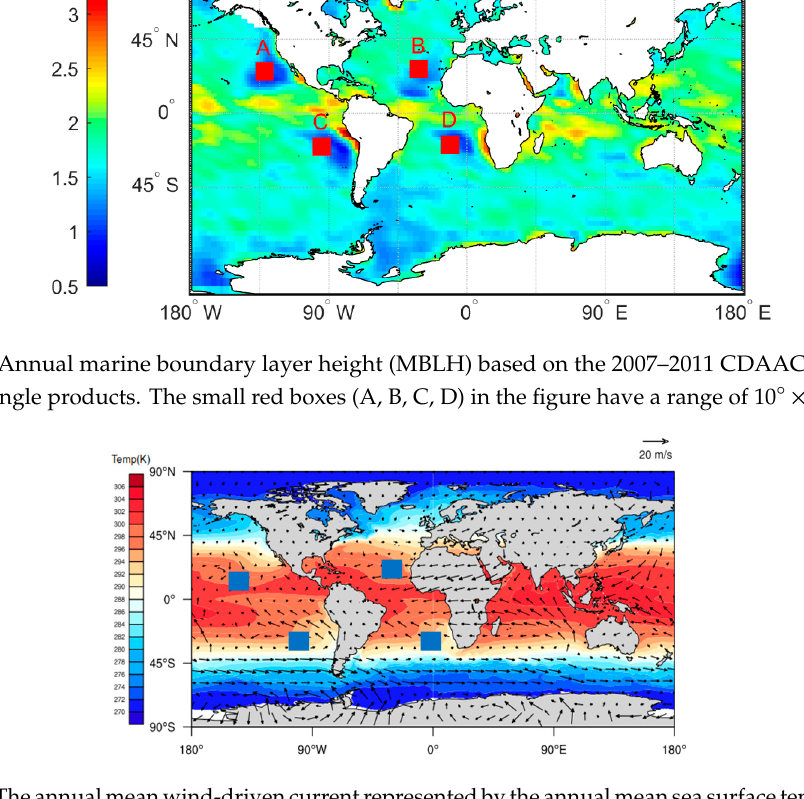
Figure 4. The annual mean wind-driven current represented by the annual mean sea surface temperature field and wind field. The black boxes indicate cold currents. The small blue box. corresponds to the four A, B, C, D areas in Figure 4.